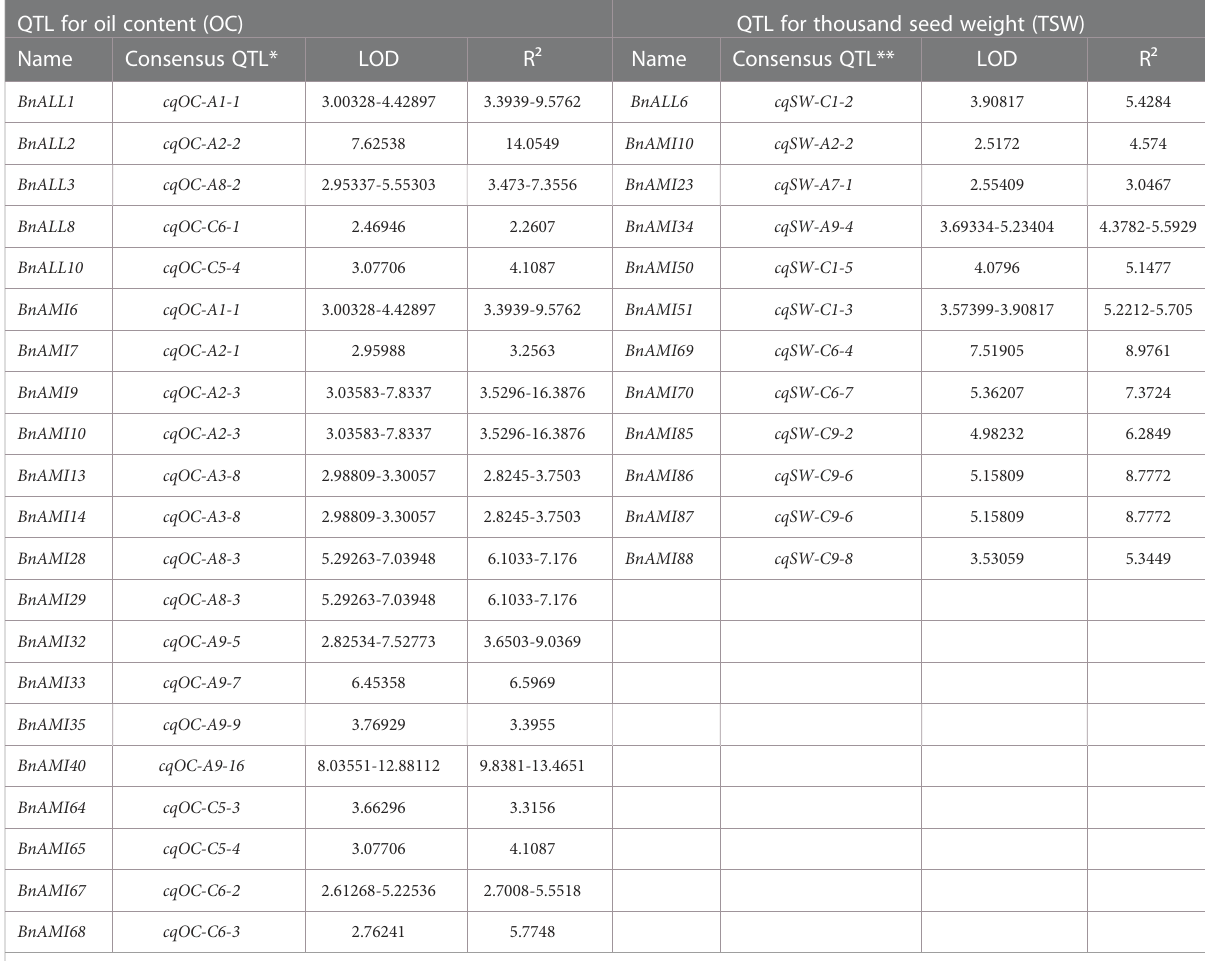
TABLE 2 Analysis of the QTL interval of the BnTAR genes. QTL for oil content (OC) QTL for thousand seed weight